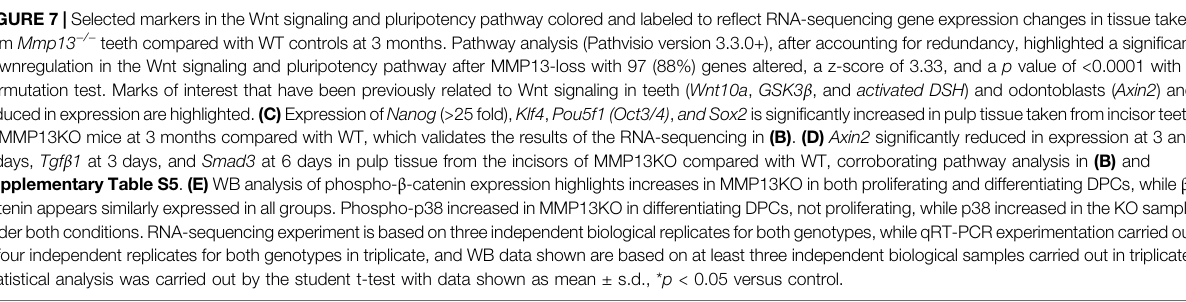
FIGURE 7 | Selected markers in the Wnt signaling and pluripotency pathway colored and labeled to re fl ect RNA-sequencing gene expression changes in tissue taken from Mmp13 − / − teeth compared with WT controls at 3 months. Pathway analysis (Pathvisio version 3.3.0+), after accounting for redundancy, highlighted a signi fi cant downregulation in the Wnt signaling and pluripotency pathway after MMP13-loss with 97 (88%) genes altered, a z-score of 3.33, and a p value of < 0.0001 with a permutation test. Marks of interest that have been previously related to Wnt signaling in teeth ( Wnt10a , GSK3 β , and activated DSH ) and odontoblasts ( Axin2 ) and reducedinexpressionarehighlighted. (C) Expressionof Nanog ( > 25fold), Klf4 , Pou5f1(Oct3/4) , andSox2 issigni fi cantlyincreasedinpulptissuetakenfromincisorteeth of MMP13KO mice at 3 months compared with WT, which validates the results of the RNA-sequencing in (B) . (D) Axin2 signi fi cantly reduced in expression at 3 and 6 days, Tgf β 1 at 3 days, and Smad3 at 6 days in pulp tissue from the incisors of MMP13KO compared with WT, corroborating pathway analysis in (B) and Supplementary Table S5 . (E) WB analysis of phospho- β -catenin expression highlights increases in MMP13KO in both proliferating and differentiating DPCs, while β - catenin appears similarly expressed in all groups. Phospho-p38 increased in MMP13KO in differentiating DPCs, not proliferating, while p38 increased in the KO sample underbothconditions.RNA-sequencingexperimentisbasedonthreeindependentbiologicalreplicatesforbothgenotypes,whileqRT-PCRexperimentationcarriedout in four independent replicates for both genotypes in triplicate, and WB data shown are based on at least three independent biological samples carried out in triplicate. Statistical analysis was carried out by the student t-test with data shown as mean ± s.d., * p < 0.05 versus